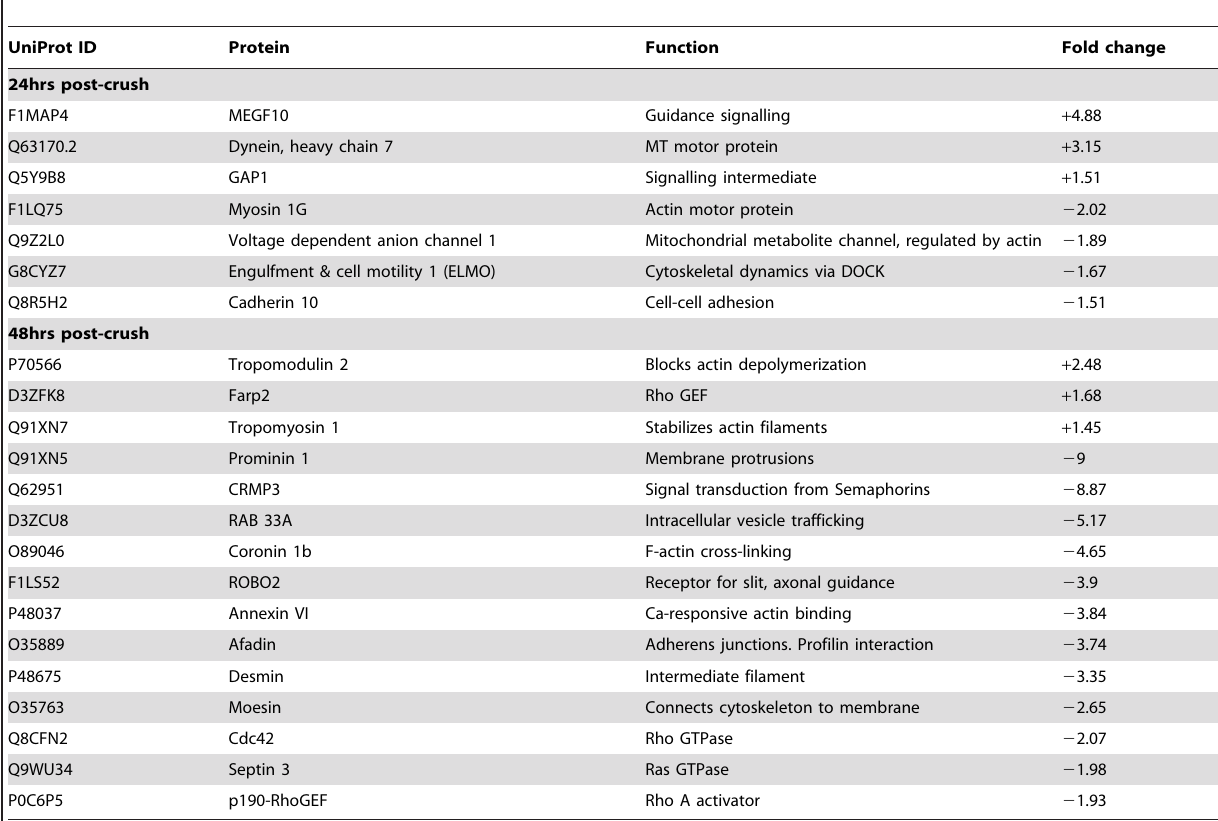
Table 1. Actin cytoskeleton associated proteins changed in injured rat optic nerve compared to naive. All fold changes were p , 0.05 significance using a student’s